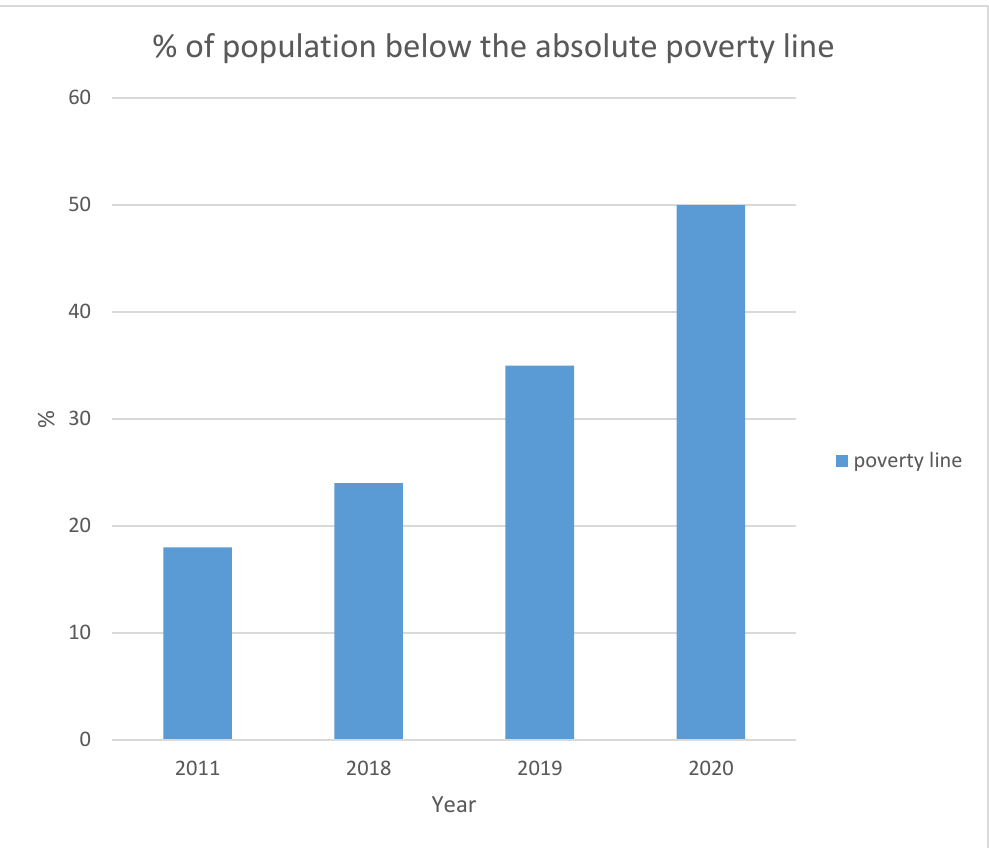
Figure 1 - % of population living in absolute poverty line 2011-2020